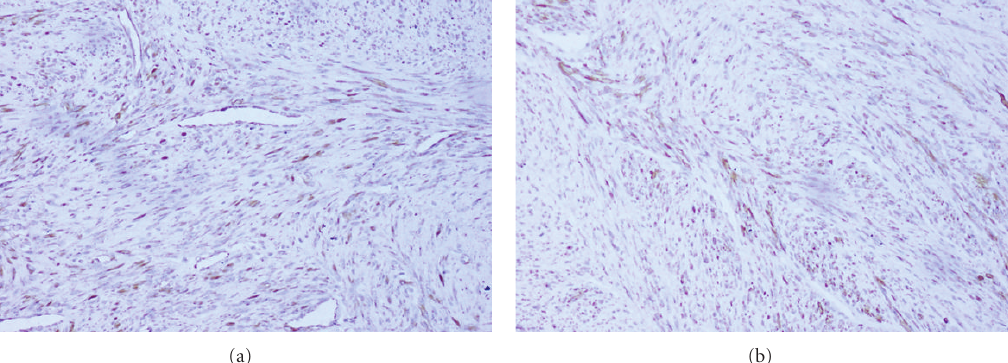
Figure 5: (a) Photomicrograph showing immunopositivity for vimentin ( × 100) and (b) photomicrograph showing immunopositivity for SMA ( ×